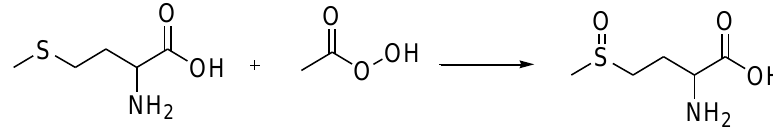
Scheme 4. Formation of methionine sulfoxide.